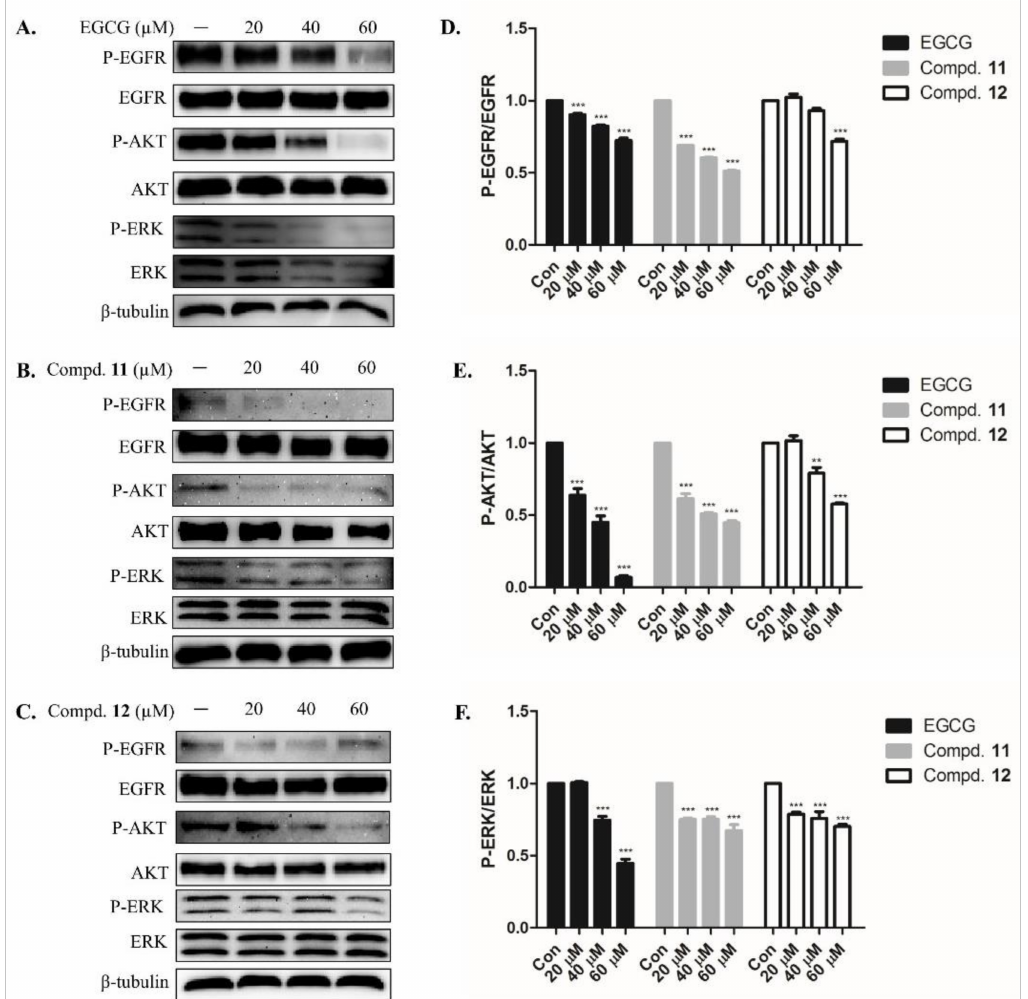
Figure 3. Effects of EGCG and its derivatives 11 and 12 on the EGCG signaling pathway in A-549 cells: ( A ) A-549 cells treated with various concentrations of EGCG (20, 40, 60 µ M); ( B ) A-549 cells treated with various concentrations of compound 11 (20, 40, 60 µ M); ( C ) A-549 cells treated with various concentrations of compound 12 (20, 40, 60 µ M); ( D ) EGCG, compound 11 and compound 12 P-EGFR quantitative analysis chart; ( E ) EGCG, compound 11, and compound 12 P-AKT quantitative analysis chart; ( F ) EGCG, compound 11, and compound 12 P-ERK quantitative analysis chart. The expression levels of the Molecules 2021 , 26 , x FOR PEER REVIEW proteins were determined by Western blotting after 24 h with β -tubulin as the loading control. Data represent the average of three independent experiments (mean ± SEM). ** p < 0.005, *** p < 0.001 vs. the control.